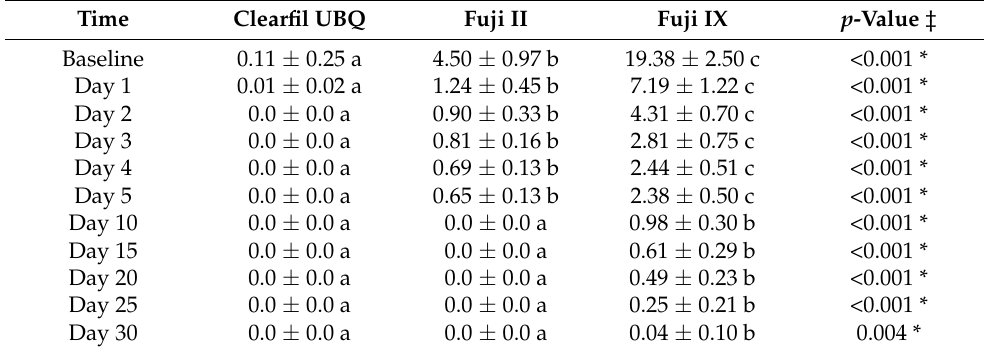
Table 2. Mean ± SD of daily fluoride release in between the three